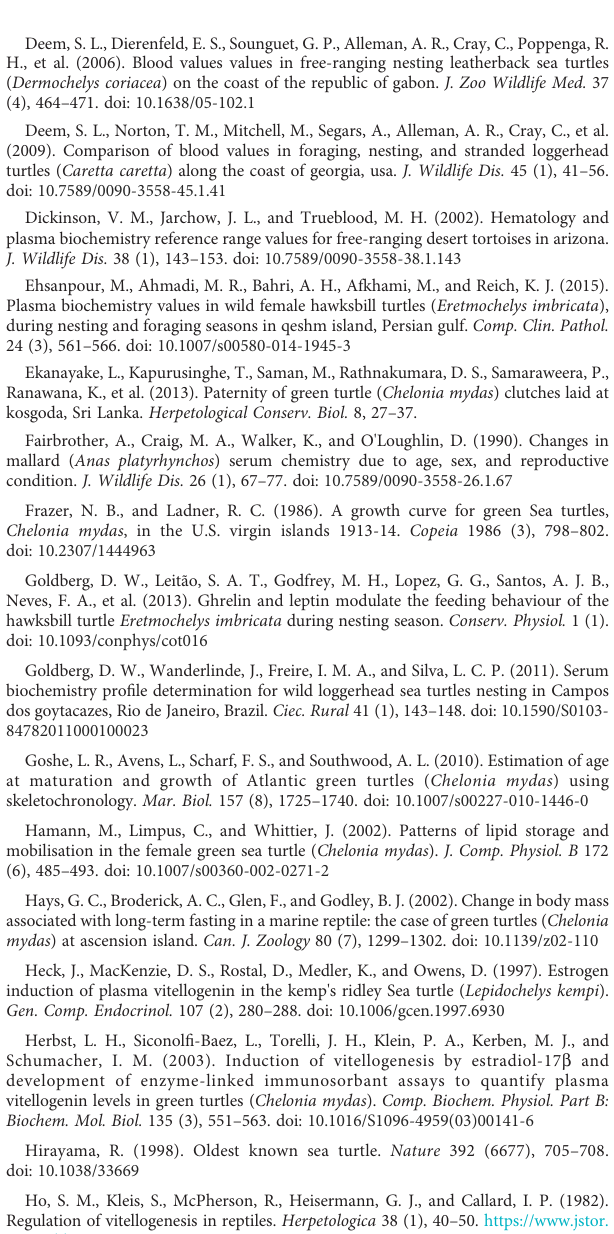
`-`. The color indicating that individual ’ s nesting status, future nesting (blue) or non-nesting (red). SUPPLEMENTARY FIGURE 5 Concentration measurements of progesterone (P4) for females that nested in 18-19 season (A) and 19-20 season (B) , in their future nesting - FN (green symbols) and nesting state (blue symbols). Measurements are represented for the (PN) season and the nesting period as marked at the X axis.